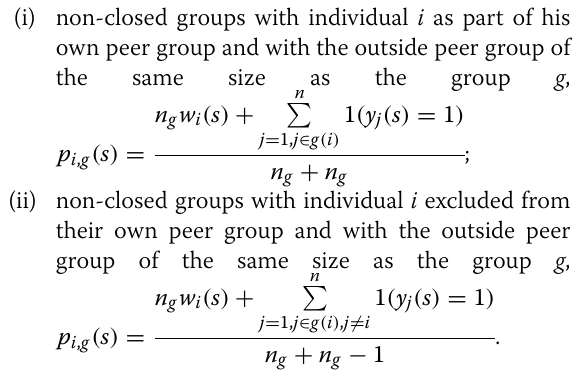
Table 8 Time performance of the Horowitz–Manski (HM) and Manski–Tamer (MT) interval estimators for the linear peer effects models (with non-closed groups and individuals excluded from their own peer group). 50 Monte Carlo